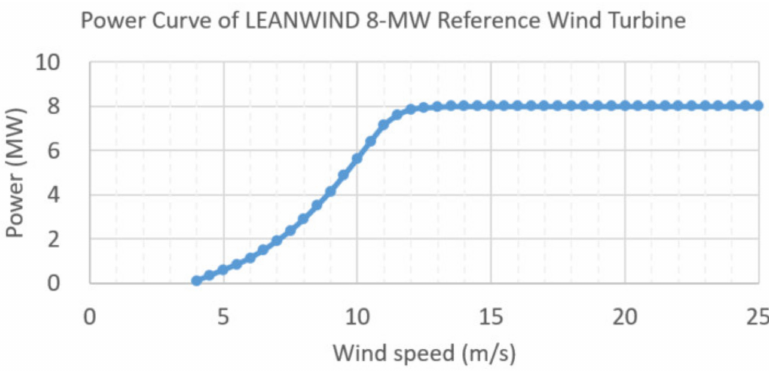
Figure 19. The power curve of LEANWIND 8MW reference wind turbine. As shown in Figure 20b, a typical corkscrew sea breeze day can produce 114,000 kwh, whereas typical backdoor sea breeze day can produce 32,310 kwh. The typical pure sea breeze day can only produce 3380 kwh. The power produced by corkscrew sea breeze was 33.7 times that of pure sea breeze and 9.6 times that of backdoor sea breeze.